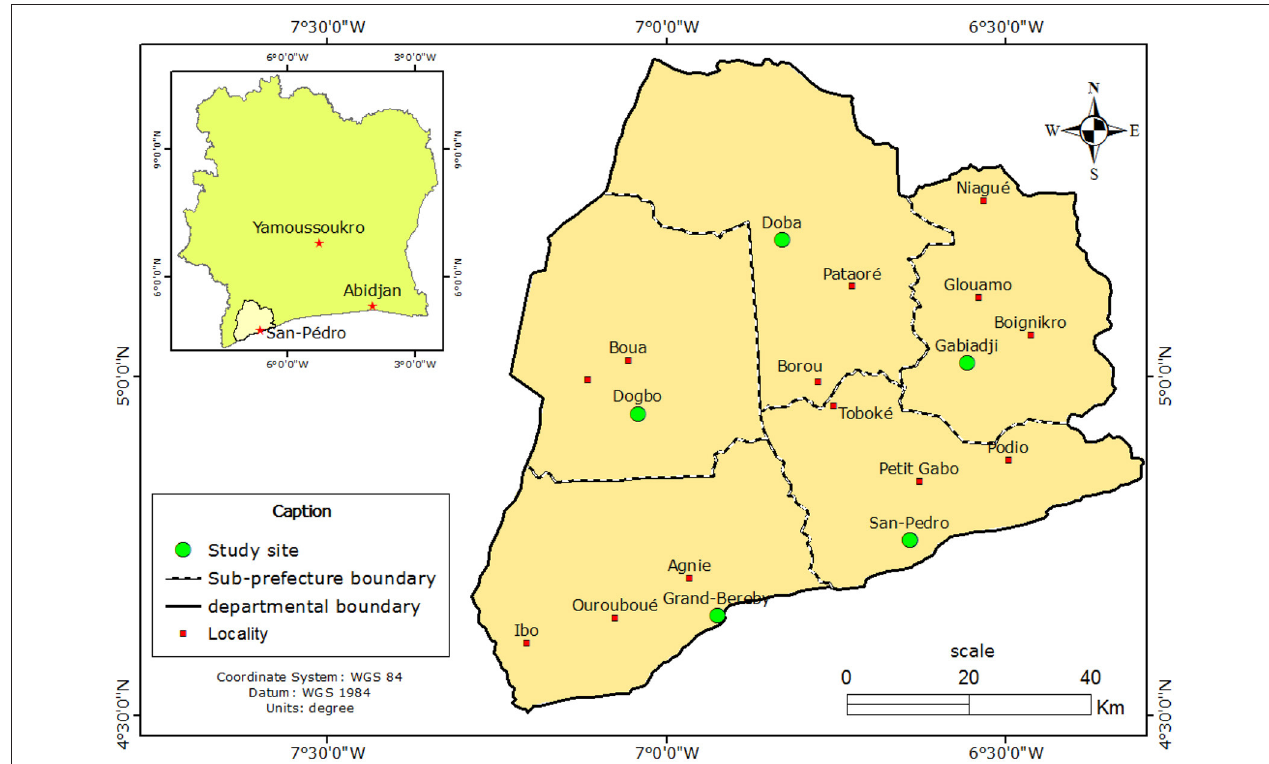
FIGURE 1 | Study site ( N = 5), cross-sectional study conducted from 14 February to 28 April 2019 in the department of San-Pedro, Côte